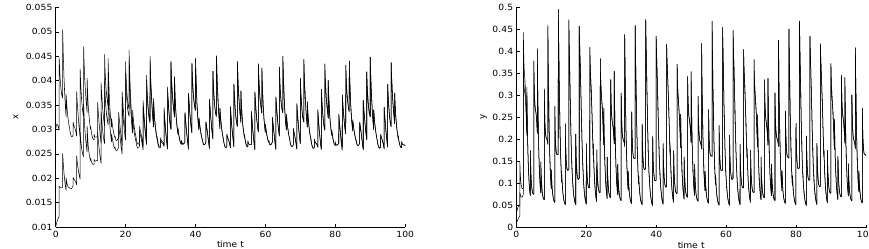
Figure 1: System (1.2) with the initial conditions (0.01, 0.01) T and (0.03, 0.03) T